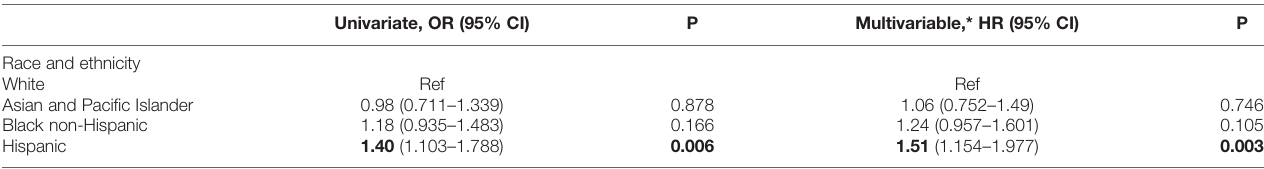
TABLE 4 | Multivariate Logistic Regression for Receiving NCCN-Concordant Adjuvant Treatment. Univariate, OR (95% CI)